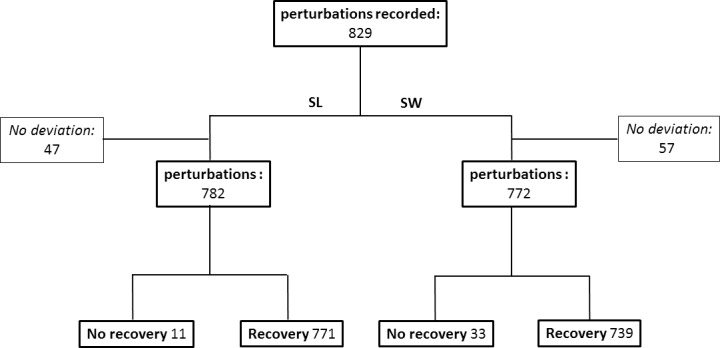
Flow chart of algorithm performance for gait parameters of step length (SL) and step width (SW).